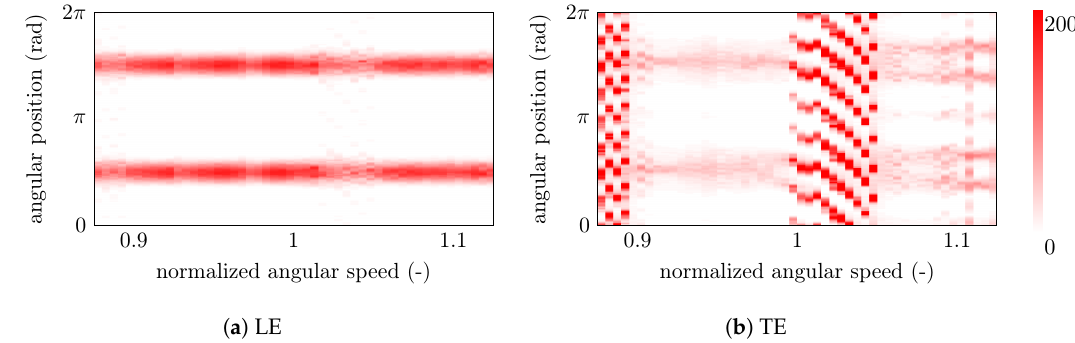
Figure 26. Evolution of the temperature profile with the angular speed for the LP compressor